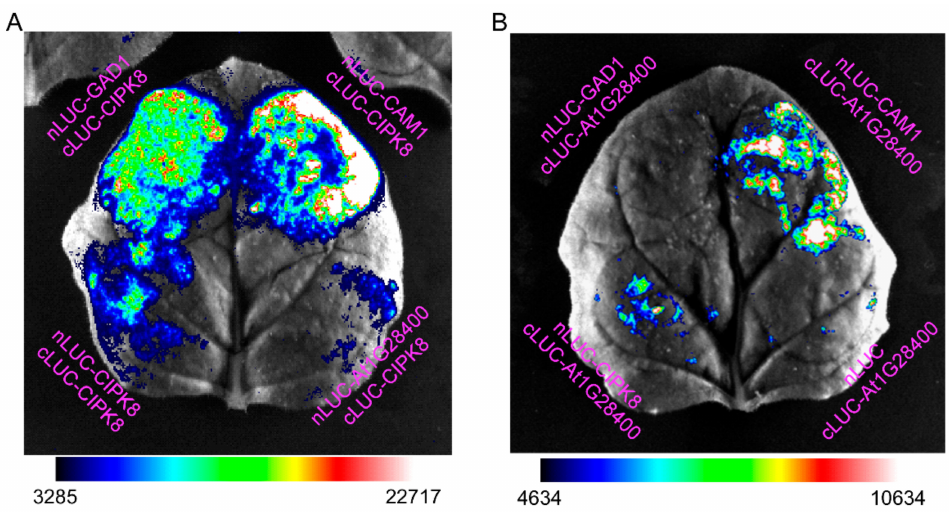
Figure 4. Interactions among four hub genes in tobacco leaves, as determined by LCI assays. ( A ) The interaction of CIPK8 with CAM1, GAD1, CIPK8 or At1G28400. ( B ) The interaction of At1G28400 with CAM1, GAD1, or CIPK8. Tobacco leaves were transformed with constructs encoding full-length GAD1 , CAM1 , CIPK8 , and At1G28400 fused with the C- or N-terminus of luciferase (c- or n-LUC). Empty vectors were used as negative controls. Luminance intensity indicates an interaction between any two proteins. The experiments were repeated three times and a representative read-out is shown. Table 1. Protein interactions among three hub genes and several [Ca 2+ ]-regulated hormone- responsive genes detected by LCI assay (Figures